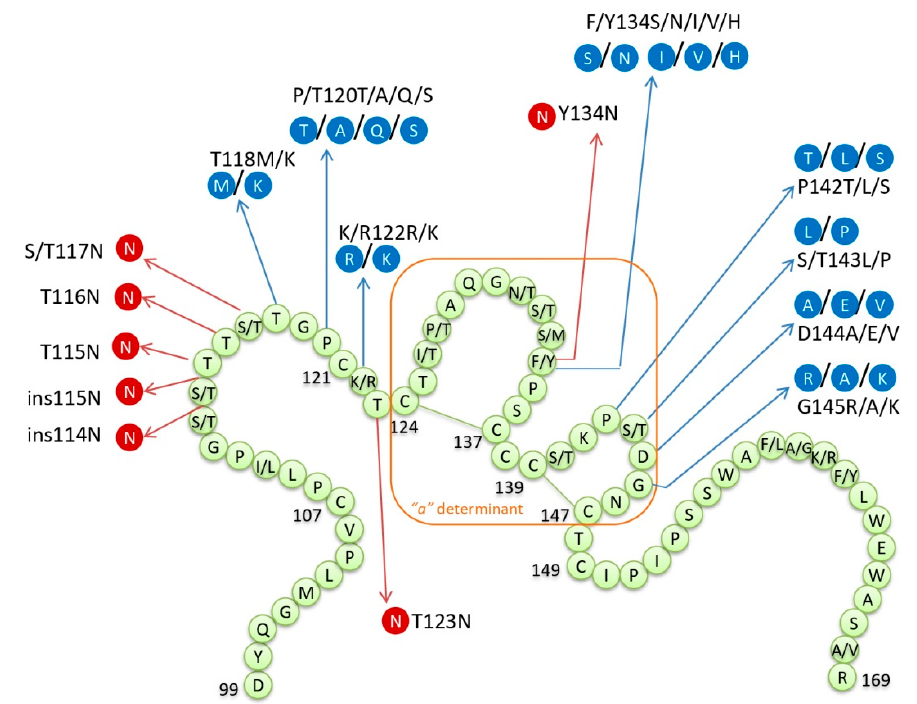
Figure 2. Major hydrophilic region (MHR) of HBsAg with the most frequent mutations and additional N -linked glycosylation (NLG) sites found in reactivated HBV; orange rectangle—“ a ” determinant within MHR; in blue—the most frequent mutations; in red—additional NLG sites.